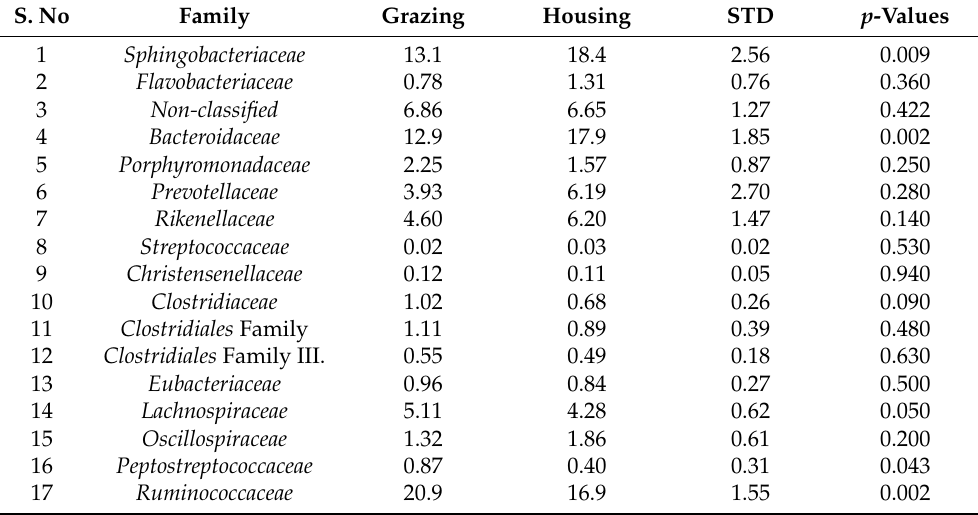
Table 2. Microbiota changes at the family level between grazing and housing steers.